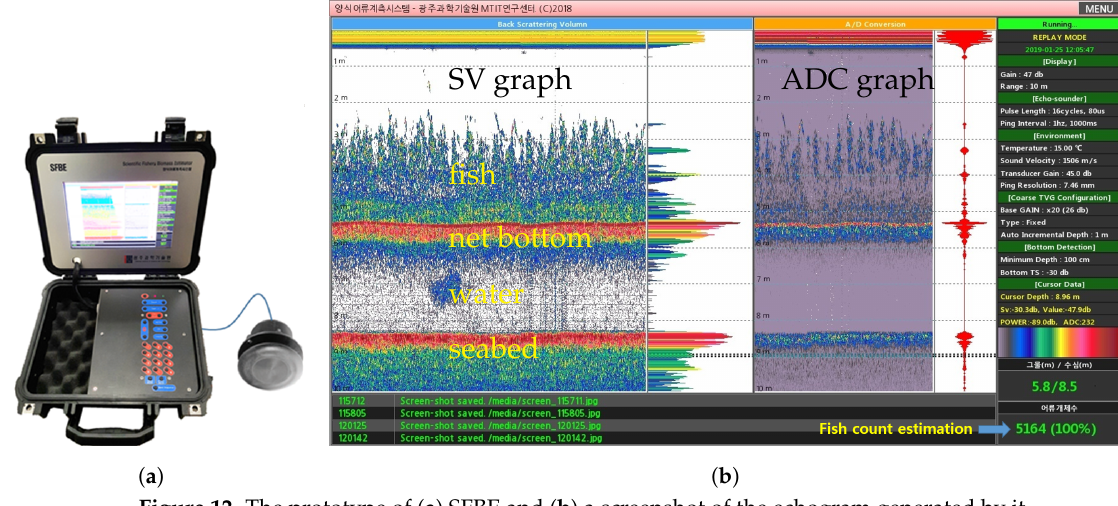
Figure 12. The prototype of ( a ) SFBE and ( b ) a screenshot of the echogram generated by